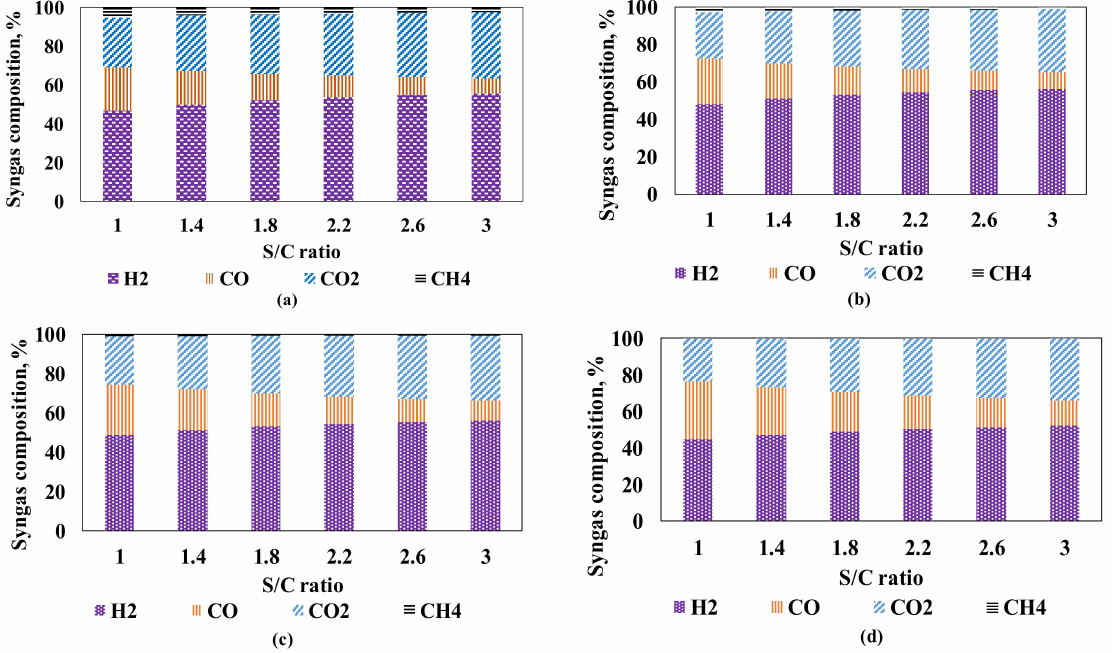
Figure 4. Syngas yield on a dry nitrogen-free basis. For the base case, ATR and shifting occur at 3 bar and H 2 recovery is carried out at 10 bar ( a ) λ = 0.23; ( b ) λ = 0.25; ( c ) λ = 0.28; ( d ) λ =